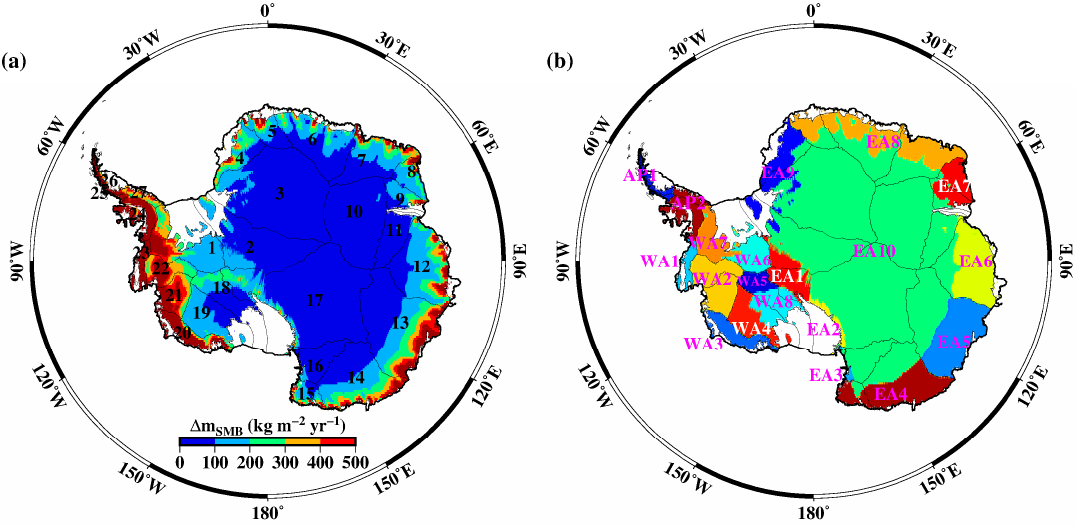
Figure 4. ( a ) The mean SMB ( ∆ m SMB ) over the time span of 2003–2009 and the Antarctic drainage systems; ( b ) The divided 20 subregions in Antarctica.